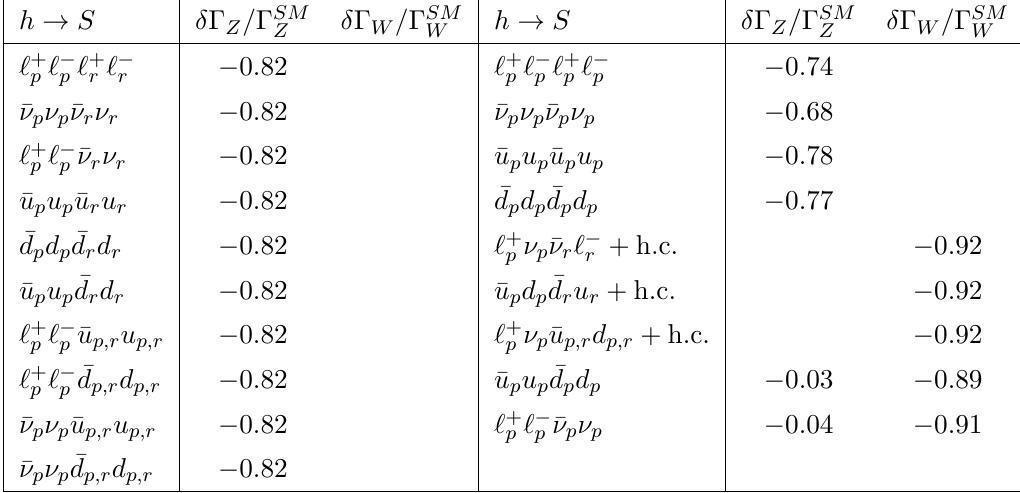
Table 6 . Coe(cid:14)cients of (cid:14) (cid:0) V = (cid:0) SM appearing in the relative SMEFT correction (cid:0) SMEFT V using the f ^ M W ; ^ M Z ; ^ G F ; ^ M h g input scheme. We distinguish channels with same- or di(cid:11)erent- (cid:13)avor fermion pairs ( p 6 = r ). The double subscript p; r indicates that both same and